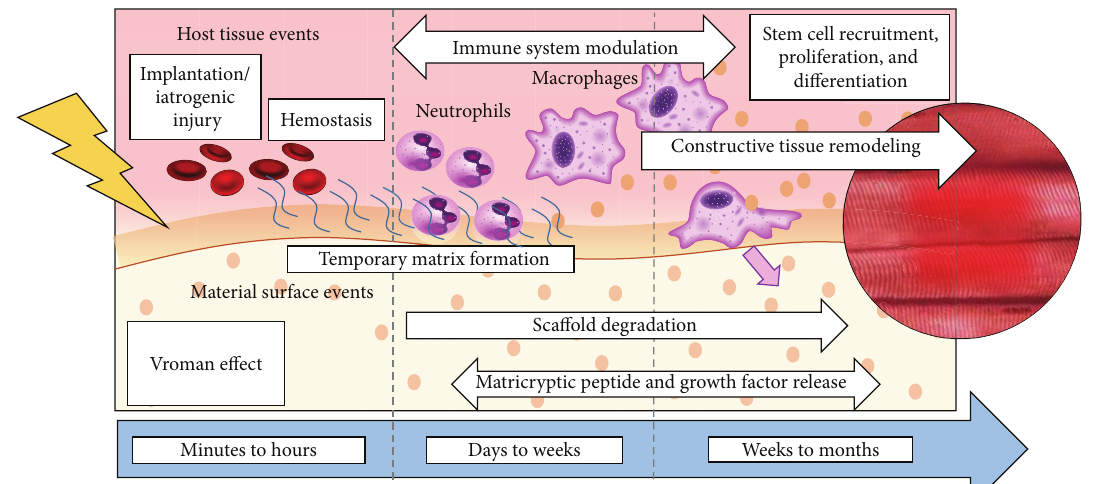
Figure 4: Biomaterial-mediated tissue repair: The biomaterial-host interaction is a complex process composed of multiples stages. Following implantation, the surface of the material is covered with blood and plasma protein through a process known as the Vroman effect. In conjunction with hemostasis, the Vroman effect facilitates the formation of a temporary fibrin-rich matrix that mediates the interaction between native tissues and the implanted construct. This temporary matrix also facilitates cellular access into the material. The innate immune system is activated and a neutrophil accumulation at the periphery of the implant becomes histologically apparent within minutes to hours of implantation. In the following days, this neutrophil accumulation is gradually replaced by a macrophage infiltrate that facilitates scaffold degradation and matricryptic peptide release. The macrophage infiltrate then transitions from an M1 proinflammatory phenotype into an M2 proremodeling phenotype. Signaling molecules produced by the innate immune system and scaffold degradation products act synergistically to recruit stem/progenitor cells from nearby tissues and the bone marrow. Together this heterogeneous cell population known as the constructive cell infiltrate is responsible for further scaffold degradation, neomatrix deposition, and constructive functional tissue